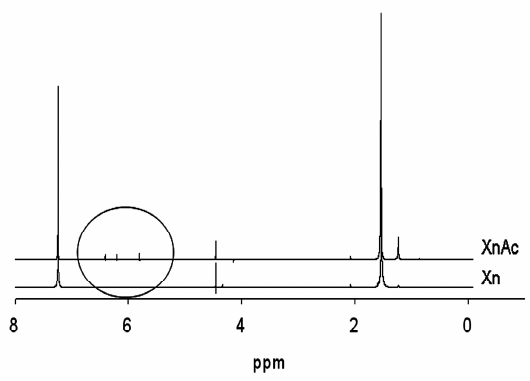
Figure 2. 1 H-NMR spectra of Xn and XnAc polymers.